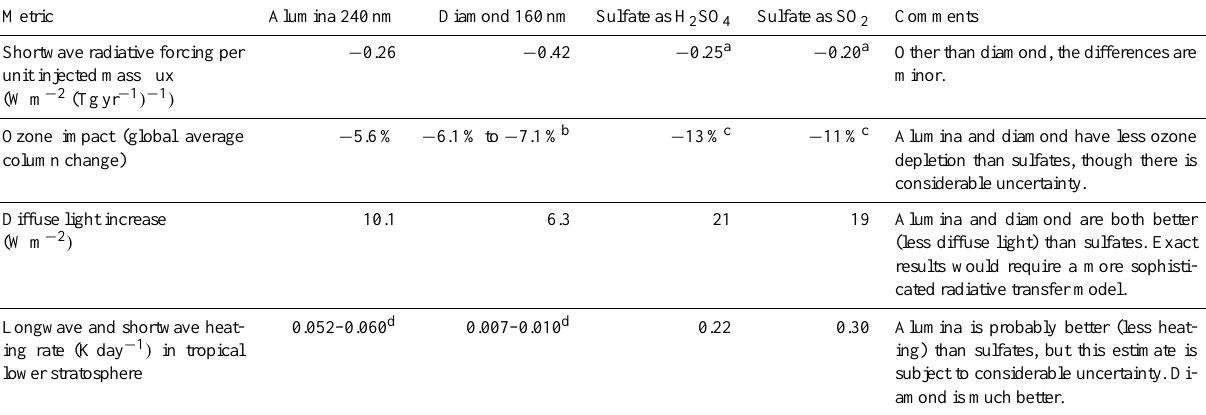
Table 2. Comparison of alumina, diamond, and sulfate solar geoengineering, based on a top-of-atmosphere shortwave radiative forcing of − 2Wm − 2 for each case. Metric Alumina 240nm Diamond 160nm Sulfate as H 2 SO 4 Sulfate as SO 2